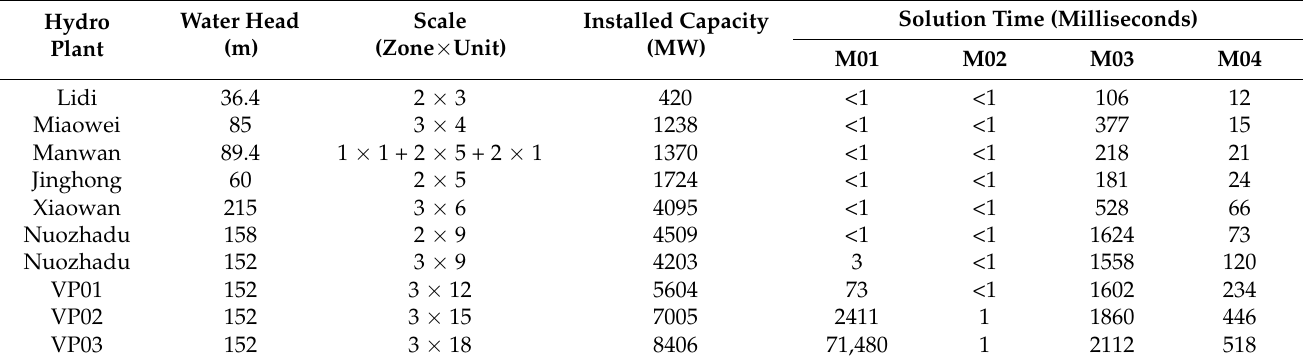
Table 3. Solution efficiency of the procedures at a precision of 0.1